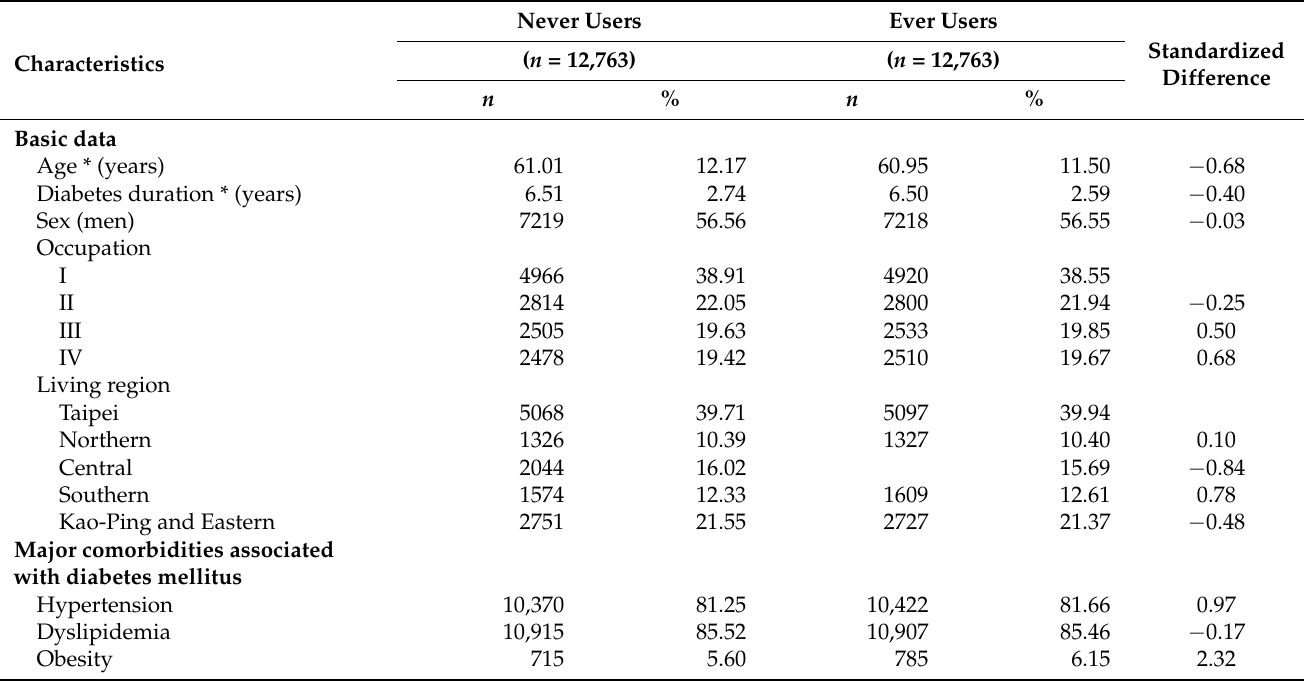
Table 1. Characteristics of pioglitazone never users and ever